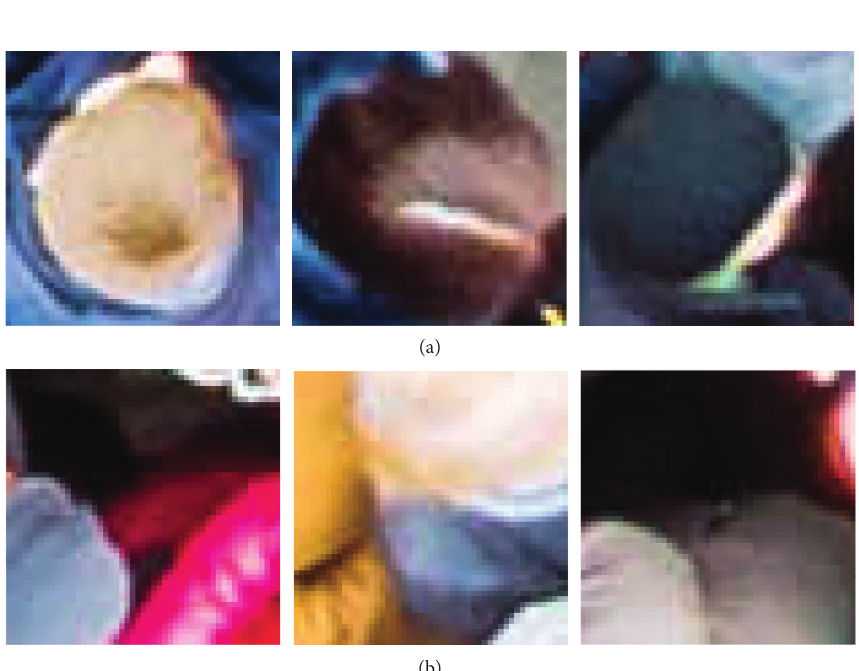
Figure 9: Examples of object images in the sets. The first three images (a) are labelled as “head” while the remaining three (b) are labelled as “not head.”